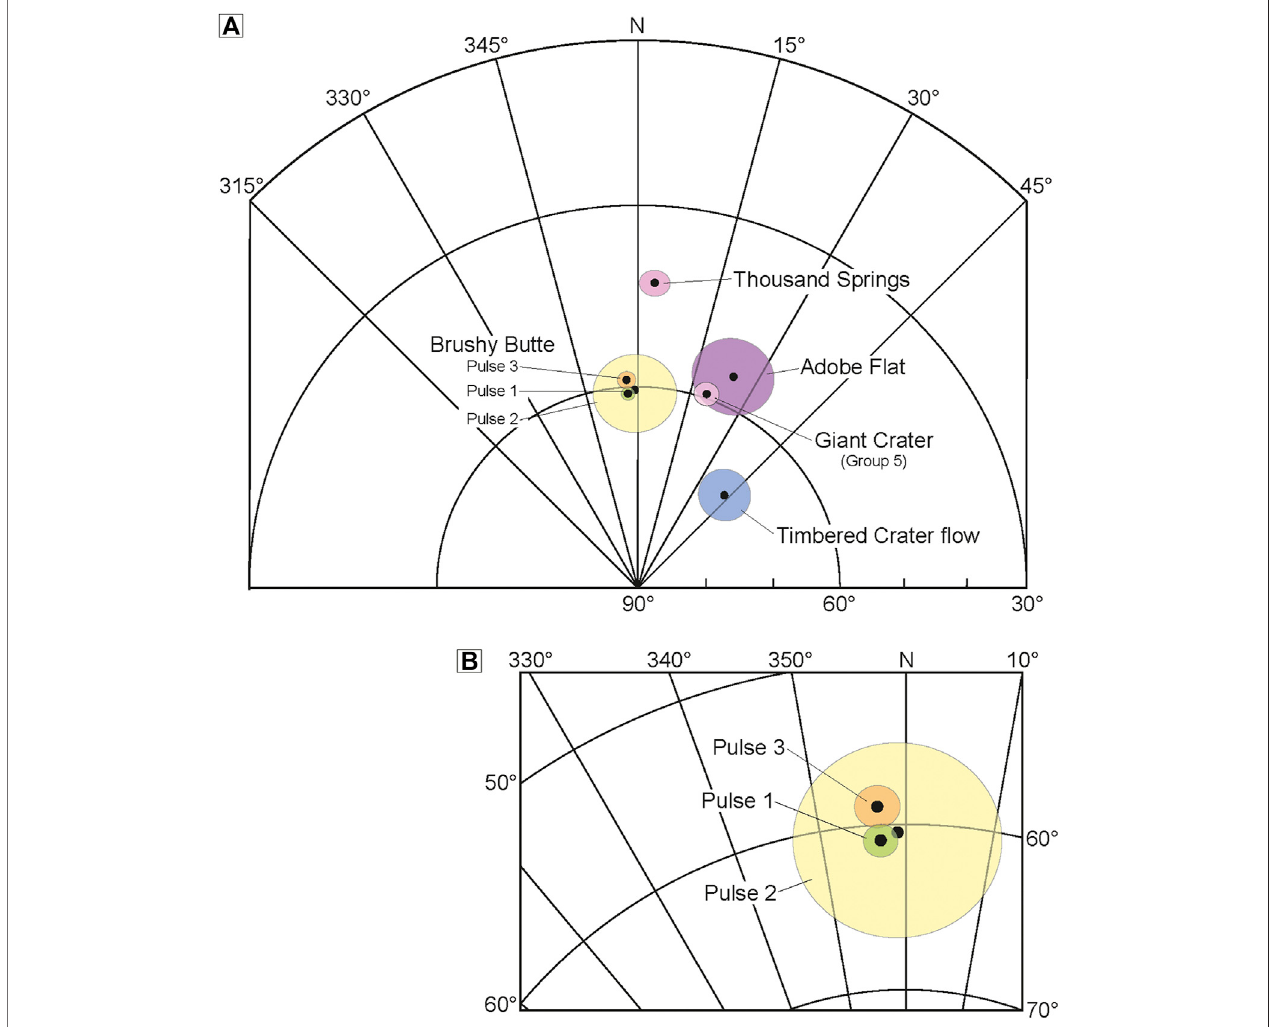
FIGURE 5 | (A) Partial equal-area projection (lower hemisphere) of average mean directions of magnetization and ovals of 95% con fi dence level ( α 95) for of pulses 1 – 3oftheBrushyButte fl ow fi eldandsurroundingtholeiiticbasalts.See Table2 forindividualsampleanalysisandforaveragesfromeacheruption. (B) Close-upviewof the average mean directions of magnetization and α 95 ovals for pulses 1 – 3 from the Brushy Butte fl ow fi eld (see Table 2 for individual sample analysis and for averages from pulses 1 – 3).